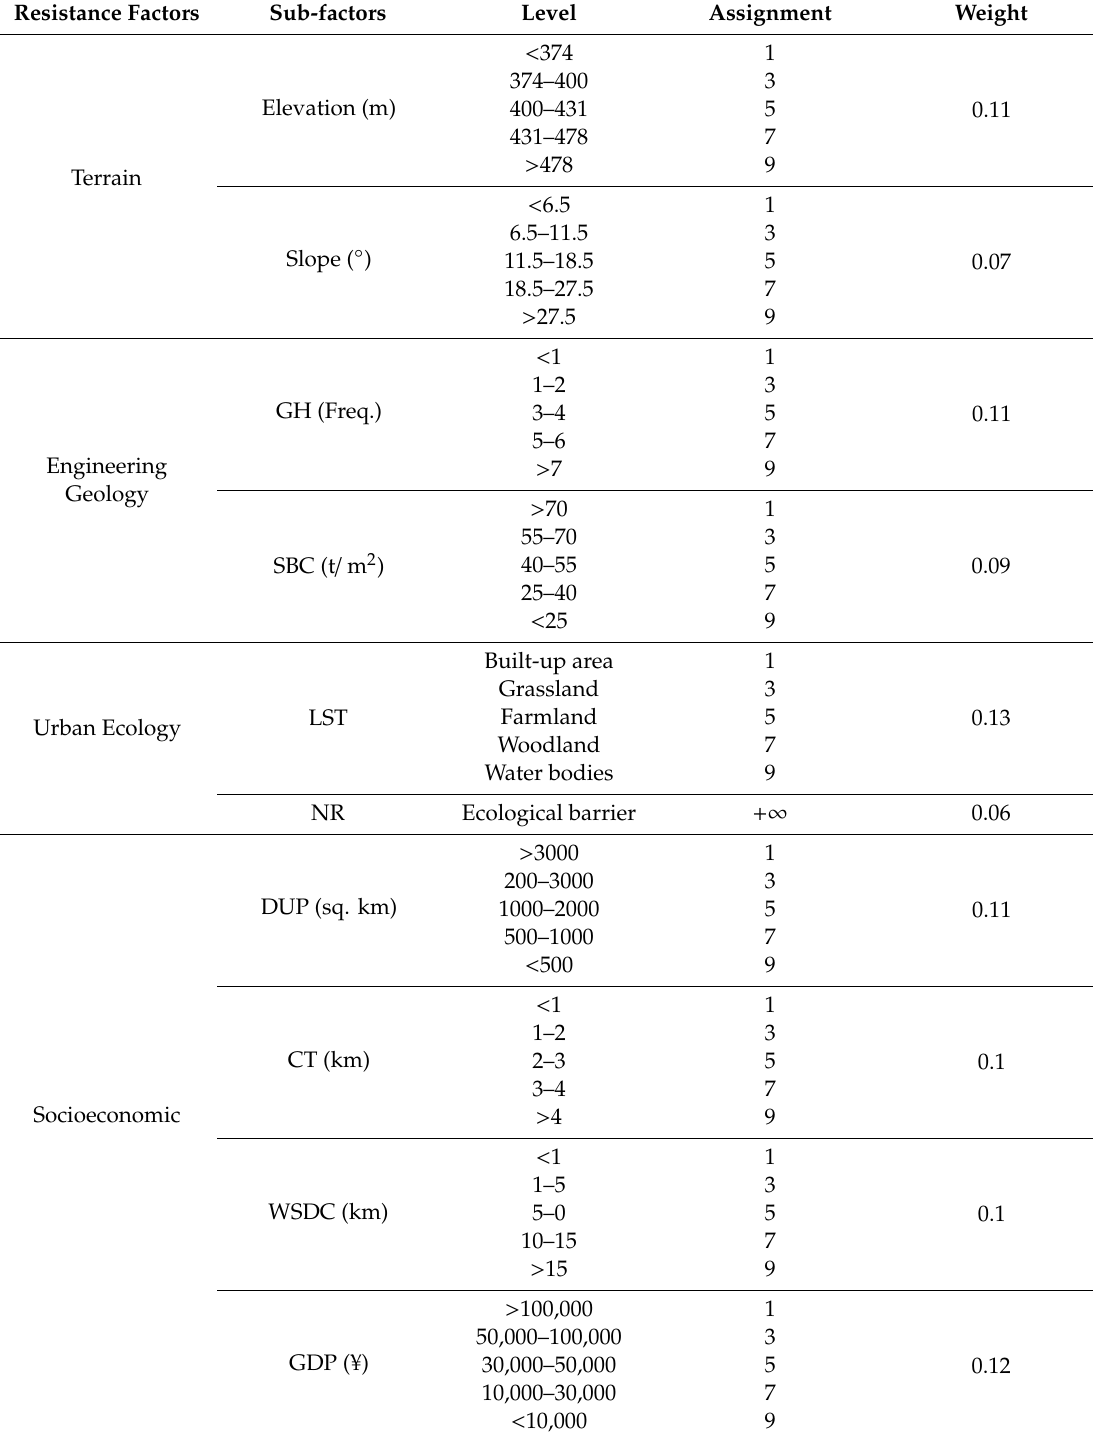
Table 2. The grade and assignment of resistance factors, and calculation results of resistance factor weight by logic regression analysis and